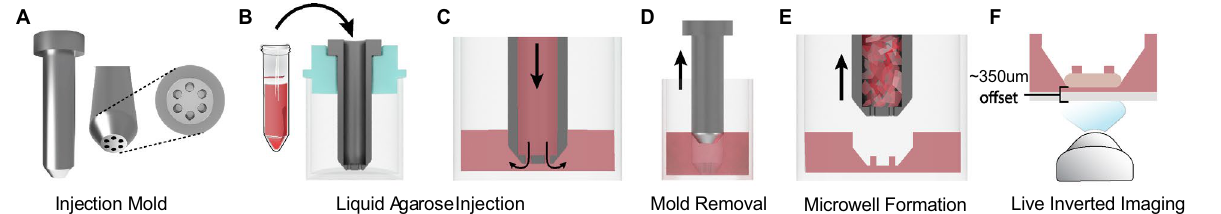
Figure 1. Custom injection mold positions the microtissue for live inverted imaging without the need for physical manipulation of tissues. ( A ) The injection mold design consists of a hollow tube with patterned end cap. The 6 holes in the endcap will form the 600 µm diameter agarose pegs of the microwell. ( B ) A cross section image of the injection molding apparatus. The injection mold (gray) is placed in the well, suspended to the correct height by a 3D printed holder (turquoise), and hot liquid agarose (red) is pushed into the hollow tube of the injection mold with a sterile syringe. ( C ) Liquid agarose moves through holes in the endcap and into the well. ( D ) When the agarose (red) is cooled, the mold can be gently pulled upward and removed. ( E ) Removal of the injection mold reveals the microwell with 6 pegs to produce the “trampoline” tissue shape. ( D ) This